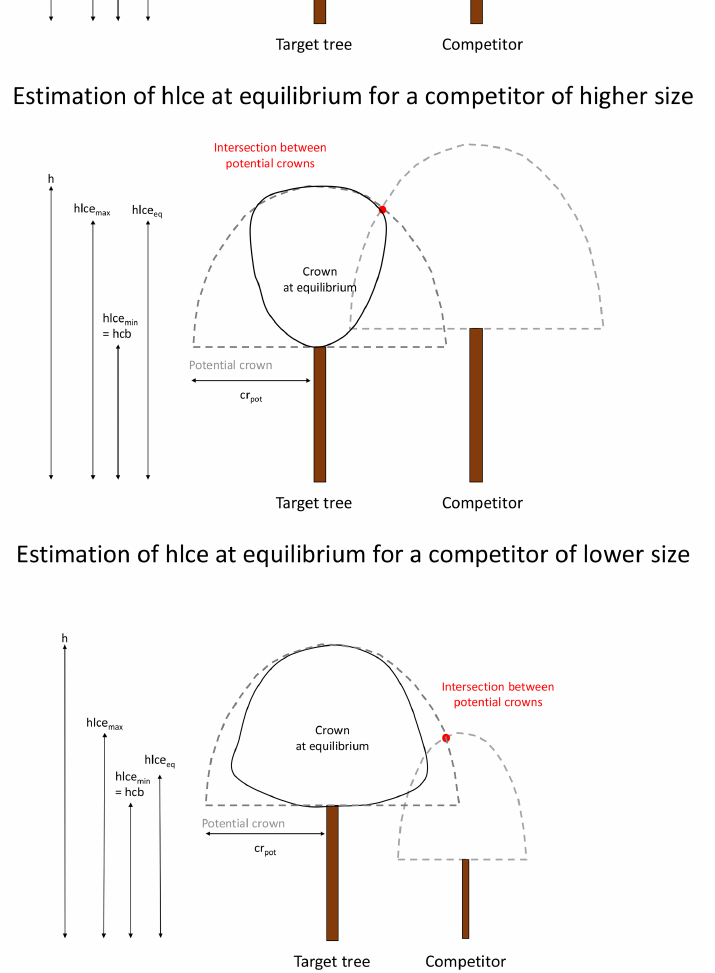
Figure D1. Illustration of the routine used to determine the height of largest crown extension at equilibrium (hlce eq ) of a target tree in three contrasting situations of competition. A first step consists in determining the intersection between the potential crown of the target tree and the competitor. Then, the hlce eq is fixed between the maximum hlce (corresponding to the intersection between potential crowns) and the minimum hlce (which is the height to crown base) based on the relative height of the